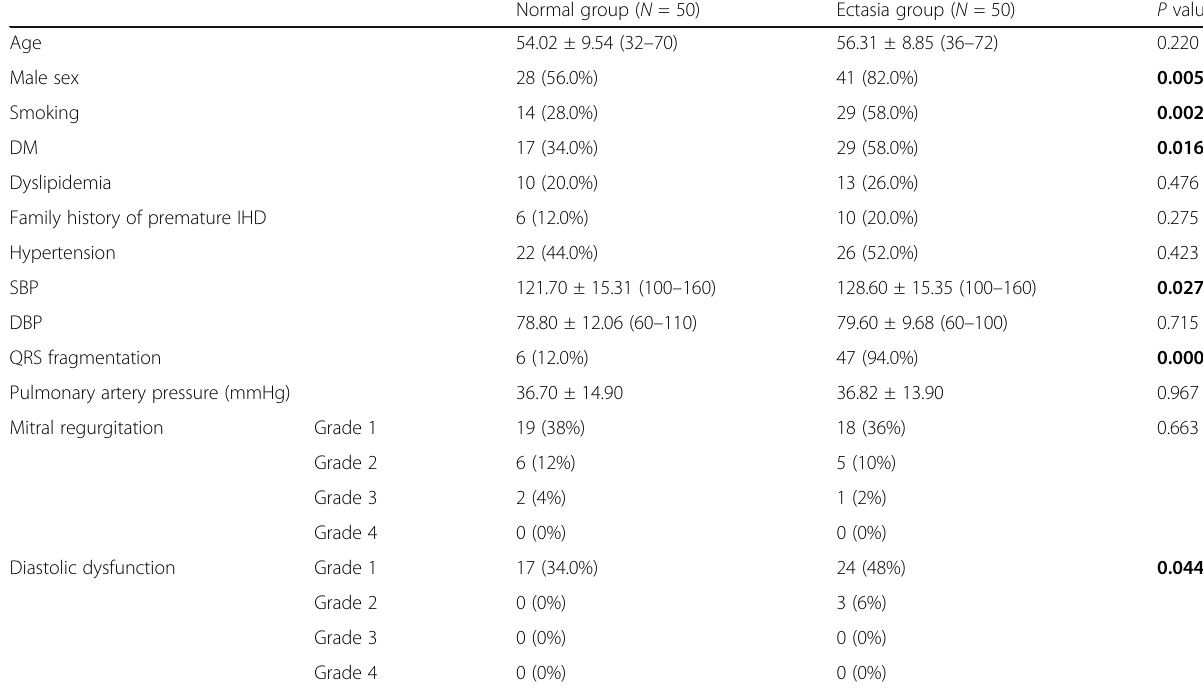
Table 2 Comparison between the 2 study groups as regards different study